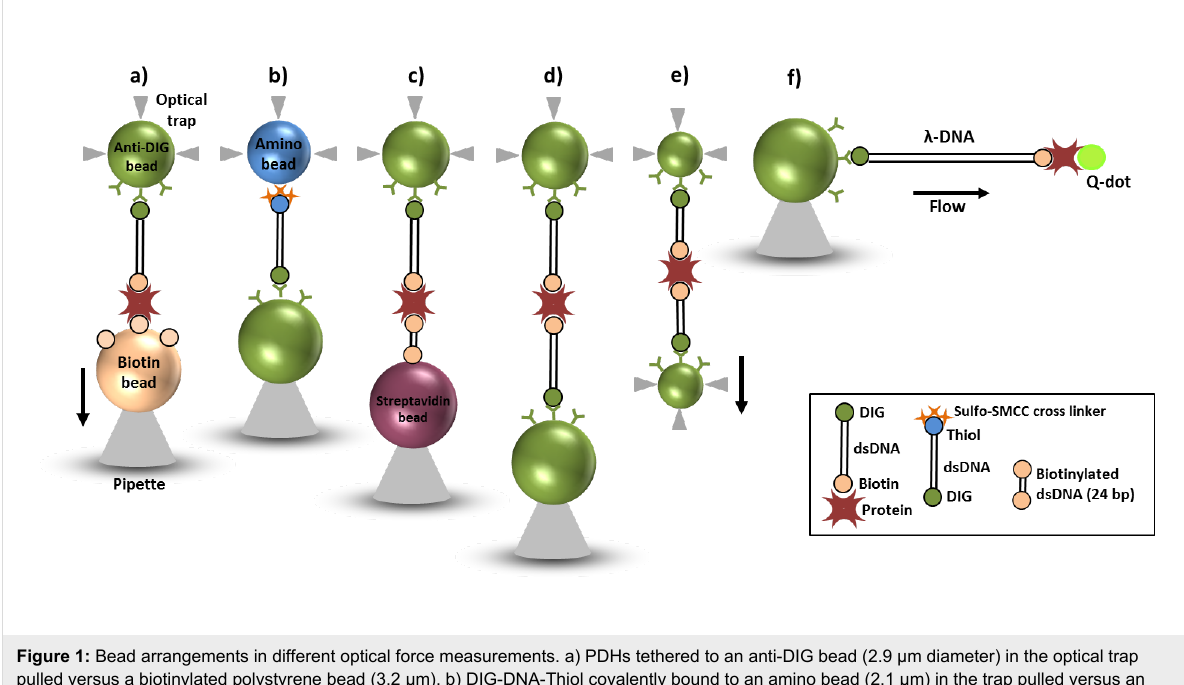
Figure 1: Bead arrangements in different optical force measurements. a) PDHs tethered to an anti-DIG bead (2.9 μ m diameter) in the optical trap pulled versus a biotinylated polystyrene bead (3.2 μ m). b) DIG-DNA-Thiol covalently bound to an amino bead (2.1 μ m) in the trap pulled versus an anti-DIG bead (3.4 μ m) in the pipette. c) Handle experiment with long DNA (3034 bp or 4056 bp) molecules: The pipette holds a streptavidin bead (3.1 μ m) modified with short dsDNA linkers (24 bp) and is probed with PDHs. d) Double handle experiment with 4056 bp or 3034 bp DHs coupled to anti-DIG bead (3.4 μ m) in the pipette and an anti-DIG bead (2.9 μ m) of different diameter with PDHs tethered to it is optically trapped. The biotin end and the protein label are interconnected in situ to form a double-length DNA handle. e) Double-handle experiment using sub-micron beads (0.84 μ m each) and short DNA molecules (1000 bp) utilizing a high-resolution dual trap OT. f) End-labelled DIG- λ -DNA-biotin bound to an anti-DIG bead (3.4 μ m) held by a micropipette. Flow forces elongate the λ -DNA molecule that is tethered at one end to the microsphere. The streptavidin-modified end (labelled with quantum dots) is freely floating in the microfluidic